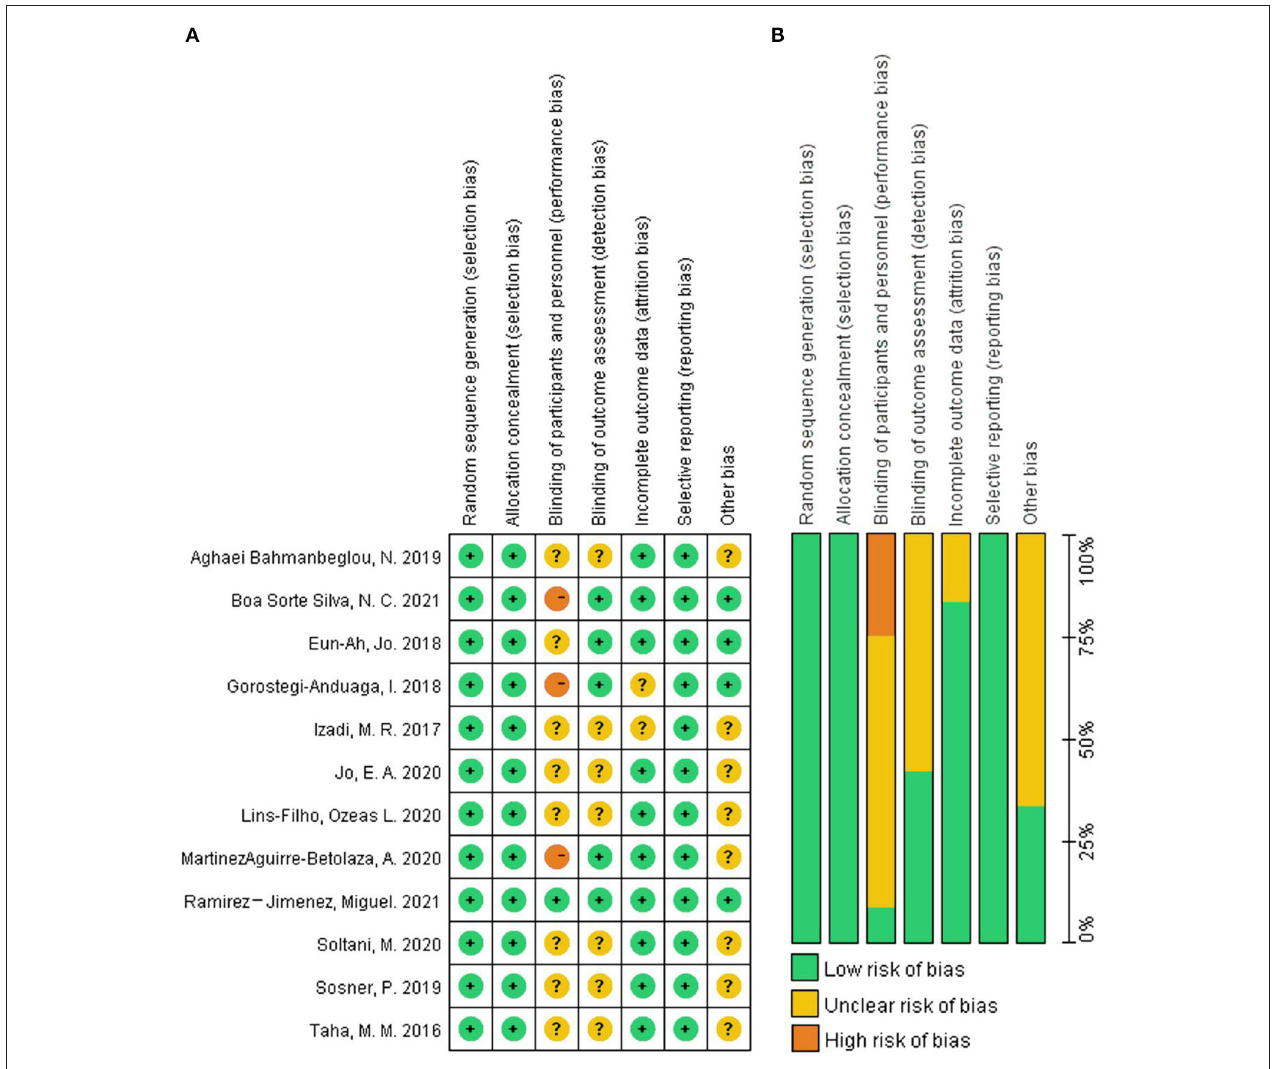
FIGURE 2 | The result of the risk of bias assessment. (A) Risk of bias graph; (B) Risk of bis